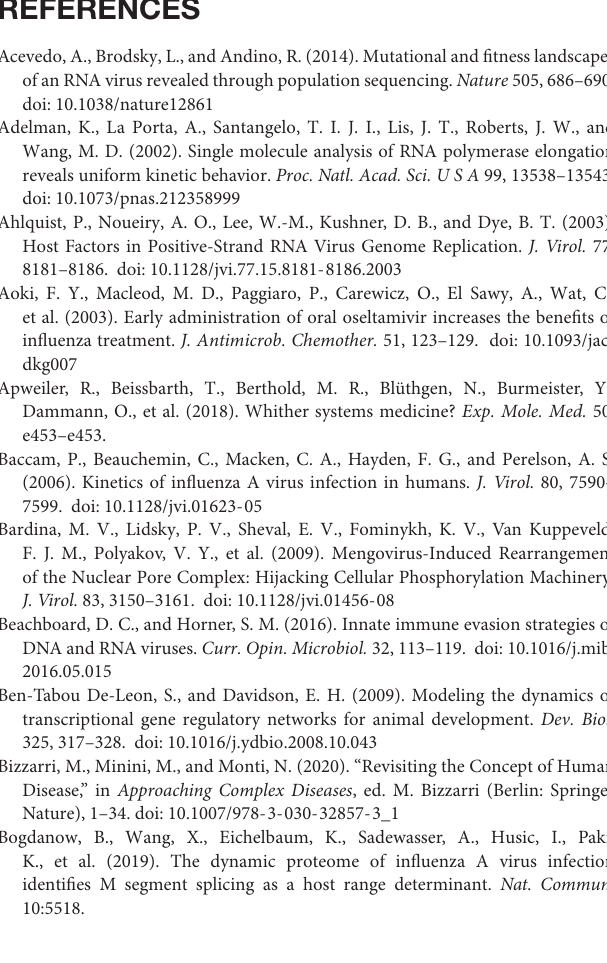
infection initial values of Q 3 stock identify the response of system, at 50 (B) , 100 (C) , 1,000 (D) , 5,000 (E) and 10,000 (F) RNA copies, expressed in ATP-eq. For Q3 stock in the range (10–1,000 RNA copies) the trajectory of Q 5 evolution was linear, while for higher initial viral load the growth of Q 5 was linear in the first day and non-linear in the further timeframe. Supplementary Figure 2 | Effects of targeting leverage point applying external driving force ( D ) at Day 1. Time change of the stocks values (for the color code see at the bottom), expressed in ATP-eq, were depicted over-time, from infection (Day 0, Time 0) through the next 7 days, upon application, at Day 1, of generic external driving forces ( D ) able to reduce the target flows (schemed on the left) of 100% or 50%, respectively. Supplementary Figure 3 | Effects of targeting leverage point applying external driving force ( D ) at Day 3. Time change of the stocks values (for the color code see at the bottom), expressed in ATP-eq, were depicted over-time, from infection (Day 0, Time 0) through the next 7 days, upon application, at Day 3, of generic external driving forces ( D ) able to reduce the target flows (schemed on the left) of 100% or 50%, respectively. Supplementary Figure 4 | Effects of targeting leverage point applying external driving force ( D ) at Day 5. Time change of the stocks values (for the color code see at the bottom), expressed in ATP-eq, were depicted over-time, from infection (Day 0, Time 0) through the next 7 days, upon application, at Day 5, of generic external driving forces ( D ) able to reduce the target flows (schemed on the left) of 100% or 50%,